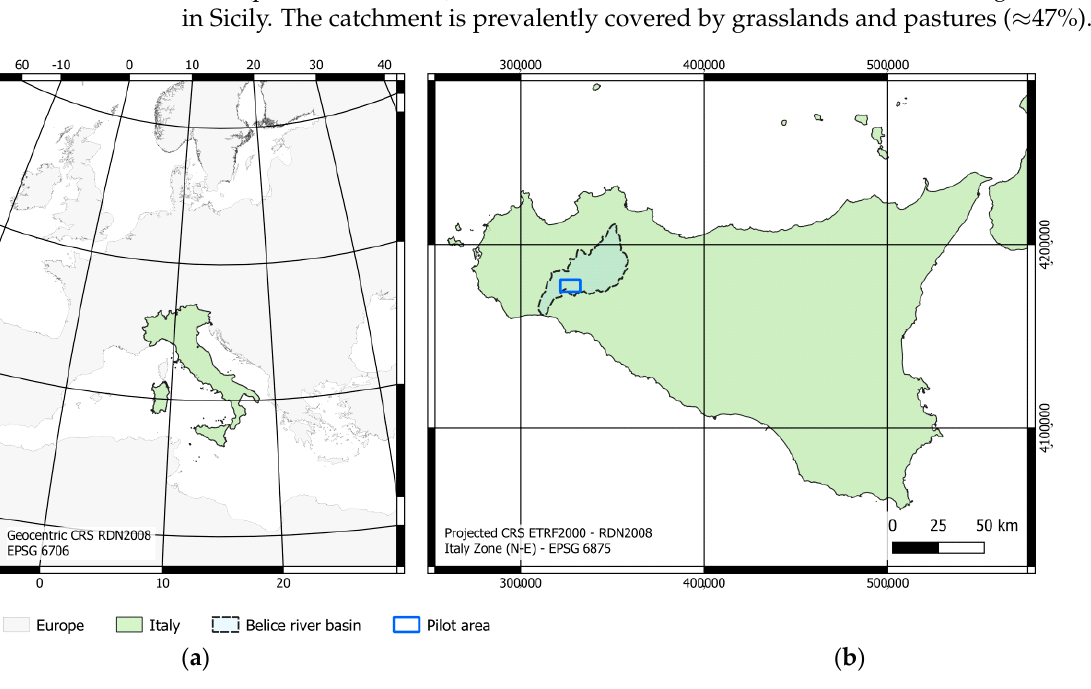
Figure 1. Location map: ( a ) Italy (light green) in Europe (light grey); ( b ) the river basin (dashed polygon) in Sicily (light green, south Italy) over-imposed the pilot area (blue rectangle). Coordinates Reference Systems (CRS) were chosen according to the Decree 10 November 2011 entitled “Adoption of the National Geodetic Reference System” issued by the Presidency of the Council of Ministers of Italy (Official Gazette General Series n.48 of 27 February 2012—Ordinary Suppl. n. 37).